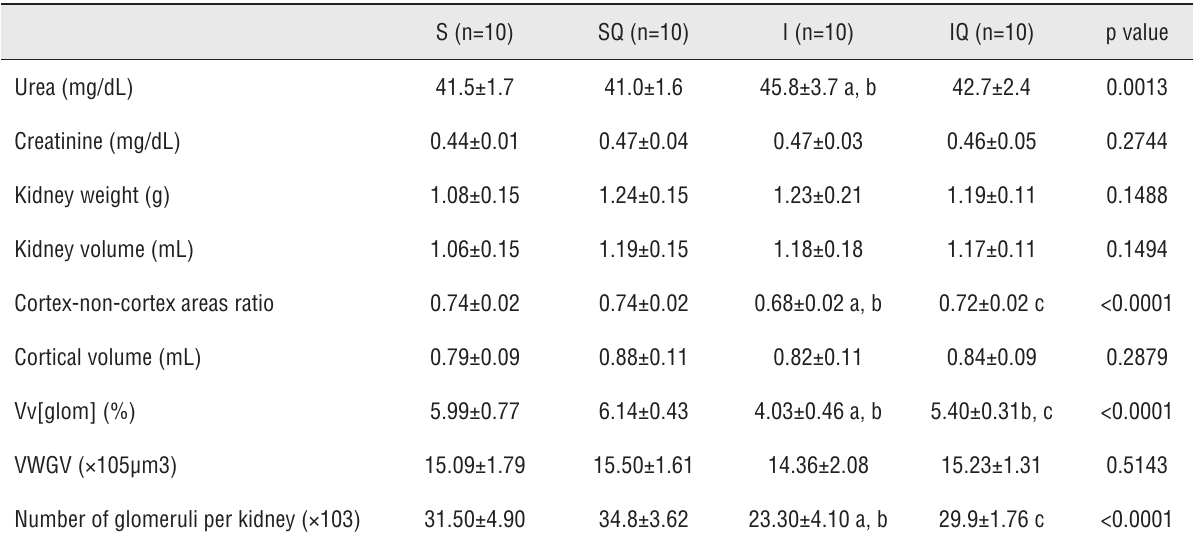
Table 1 - Kidney functional and morphological data of rats subjected to sham surgery or to left renal warm ischemia with or without quercetin